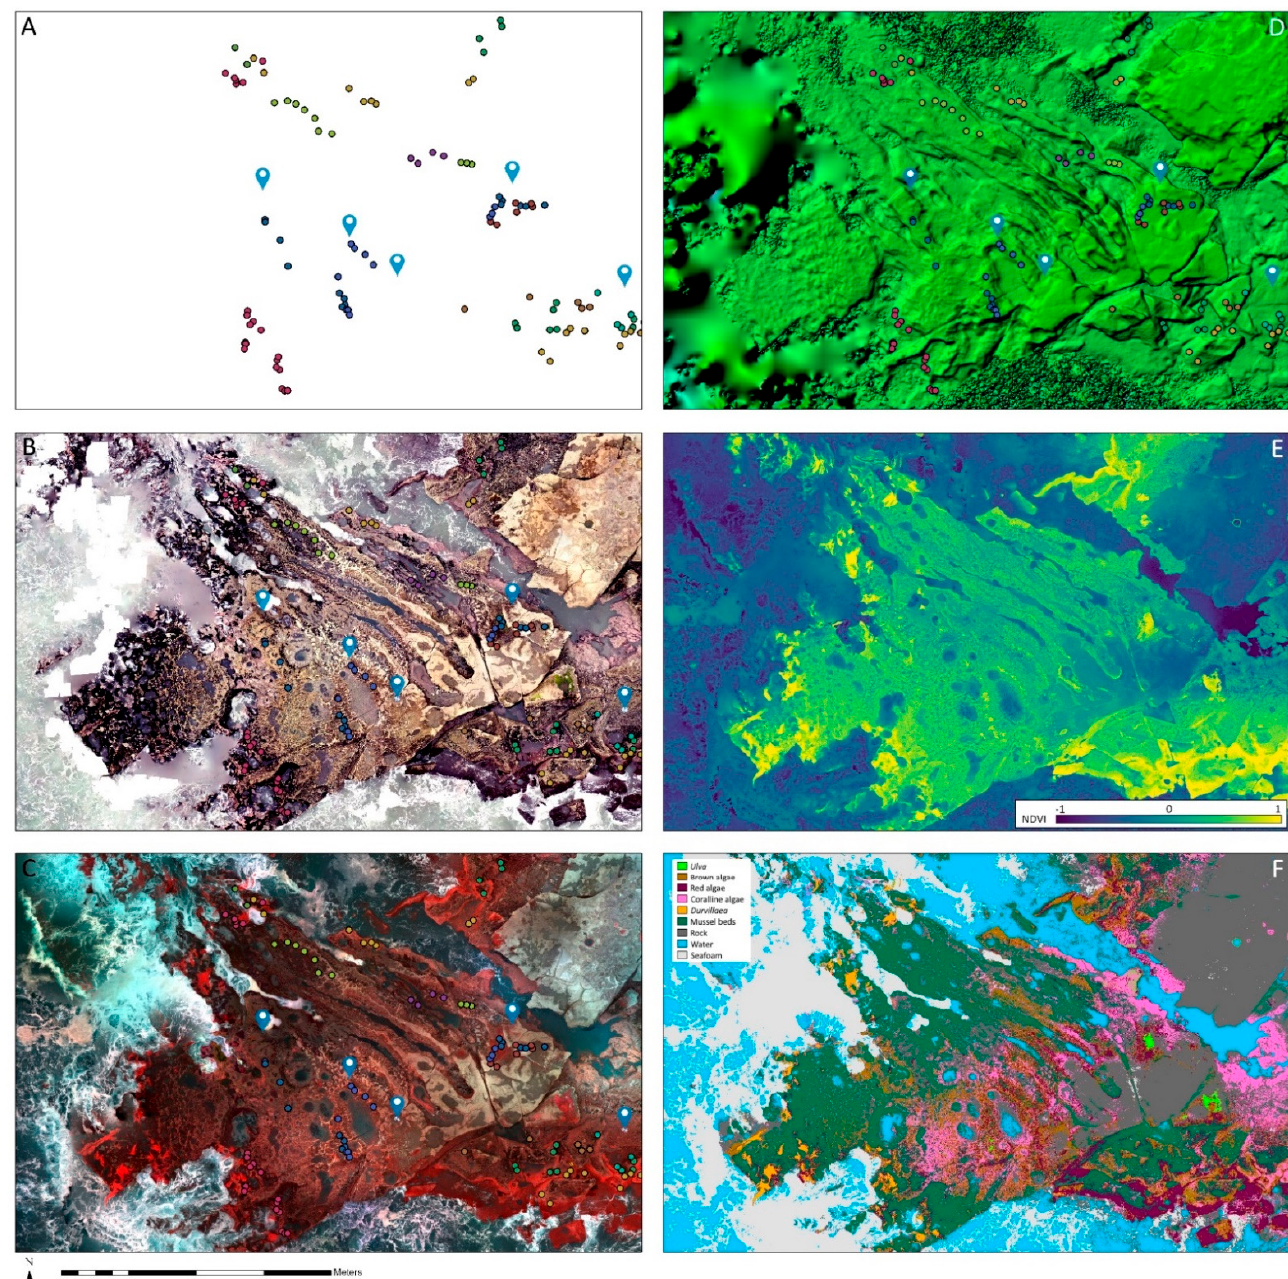
Figure 6. Layers of imagery and geospatial information of rocky reef ecosystems for performing and assessing habitat classification procedures. Layers show ( A ) locations of Ground Control Points (blue tear-drop symbols) and in situ validation samples for multiple habitat types (circles); ( B ) RGB imagery; ( C ) 6-band multispectral image (false colour image showing NIR in “red” band); ( D ) photogrammetric construction of a digital elevation model; ( E ) normalised difference vegetation index (NDVI); and ( F ) classified output.